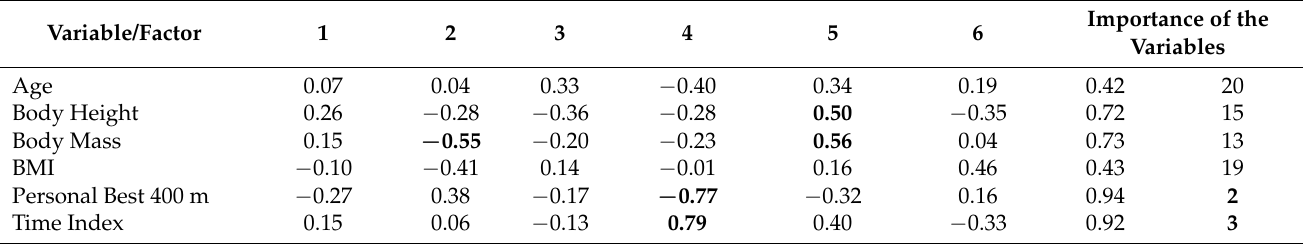
Table 8. PCA analysis of selected 400 m hurdles strategy